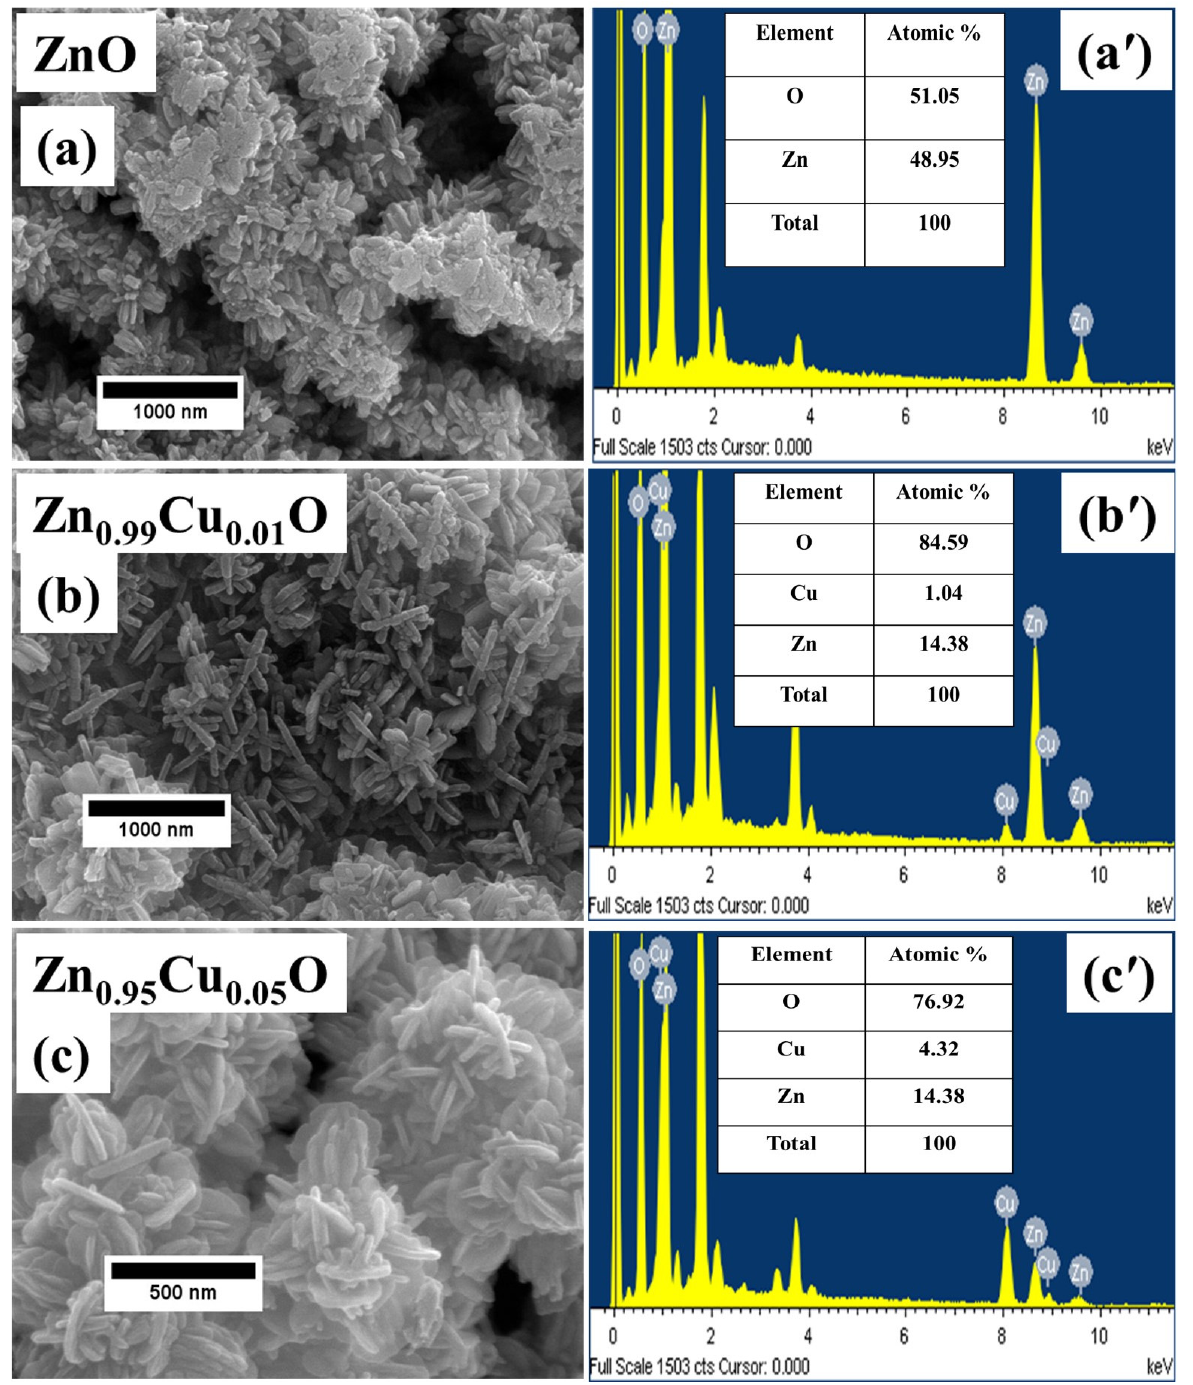
Figure 3. ( a – c ) HR-FESEM micrographs of Cu-doped ZnO nanostructures, ( a ′ – c ′ ) EDX spectra Cu- doped ZnO